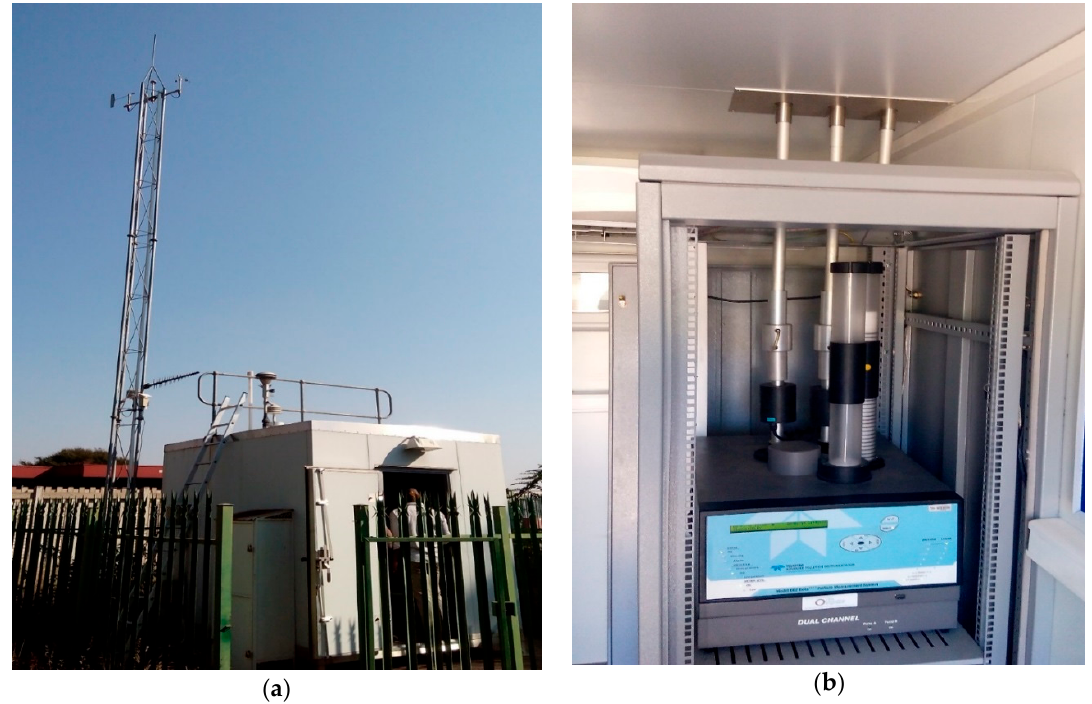
Figure 2. ( a ) A monitoring station in Pretoria West; ( b ) Beta PLUS Particle measurement system.